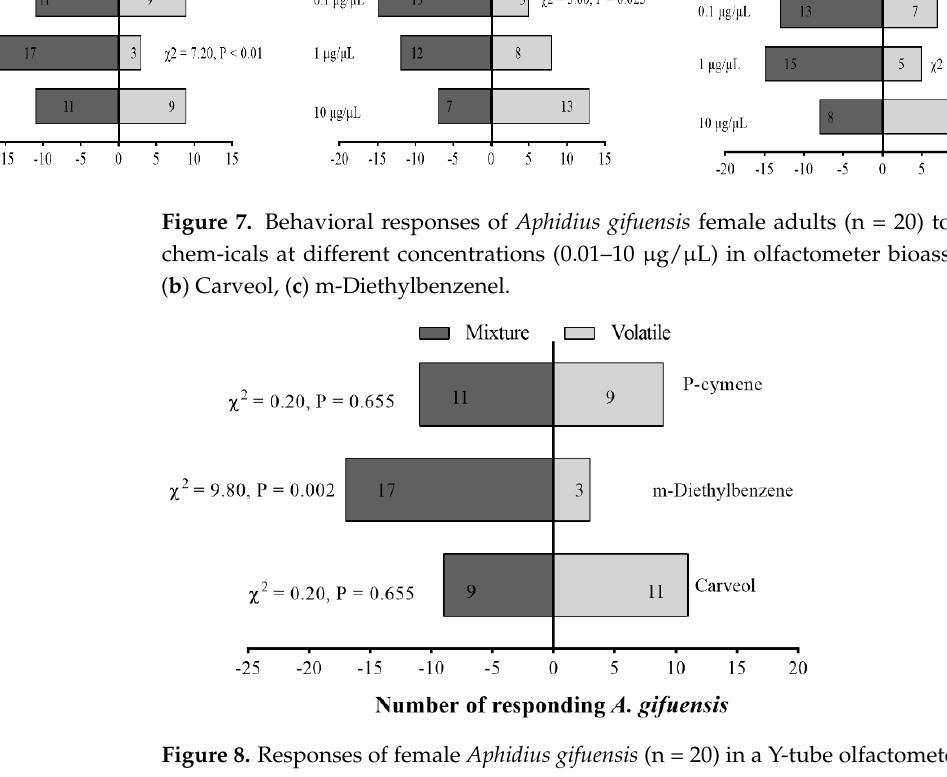
Figure 8. Responses of female Aphidius gifuensis (n = 20) in a Y-tube olfactometer to the single com- pound against mixture. The mixture was prepared from 1 µ g/ µ L p-Cymene, 0.1 µ g/ µ L Carveol and 1 µ g/ µ L m-Diethyl-benzene, the concentration of the single compound in the mixture was kept con-stant. Recipe for 1000 µ L of mixture: 1.16 µ L p-Cymene, 1.16 µ L m-Diethyl-benzene, 0.104 µ L Carveol, 997.58 µ L n-hexane.